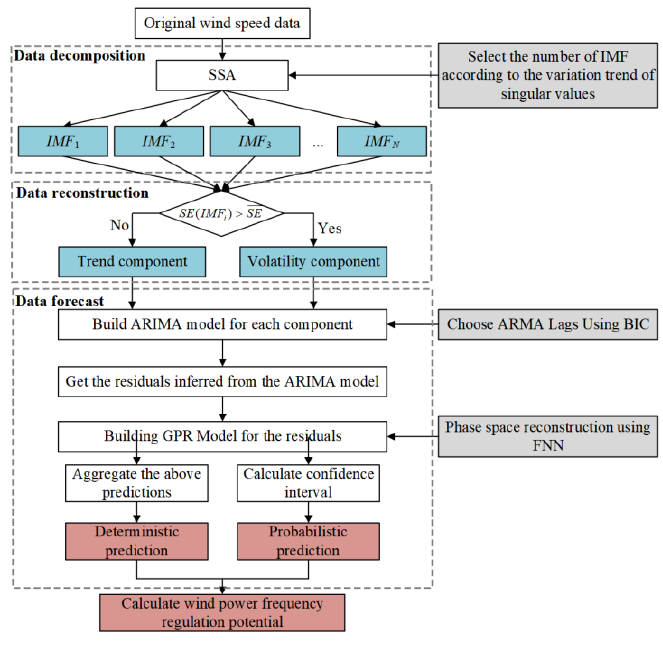
Figure 6. Framework of hybrid prediction model. (1) SSA decomposition is performed on the original wind speed series. SSA decompo-